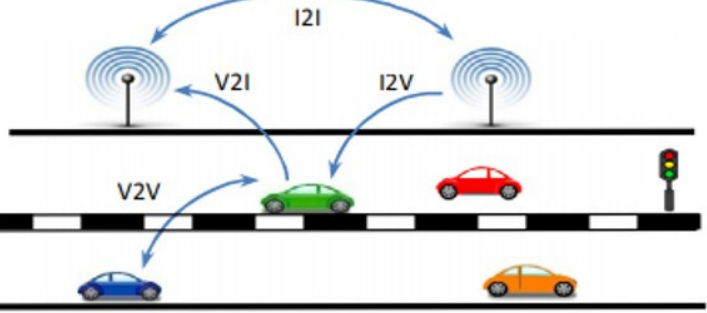
Figure 1. Types of available wireless links.